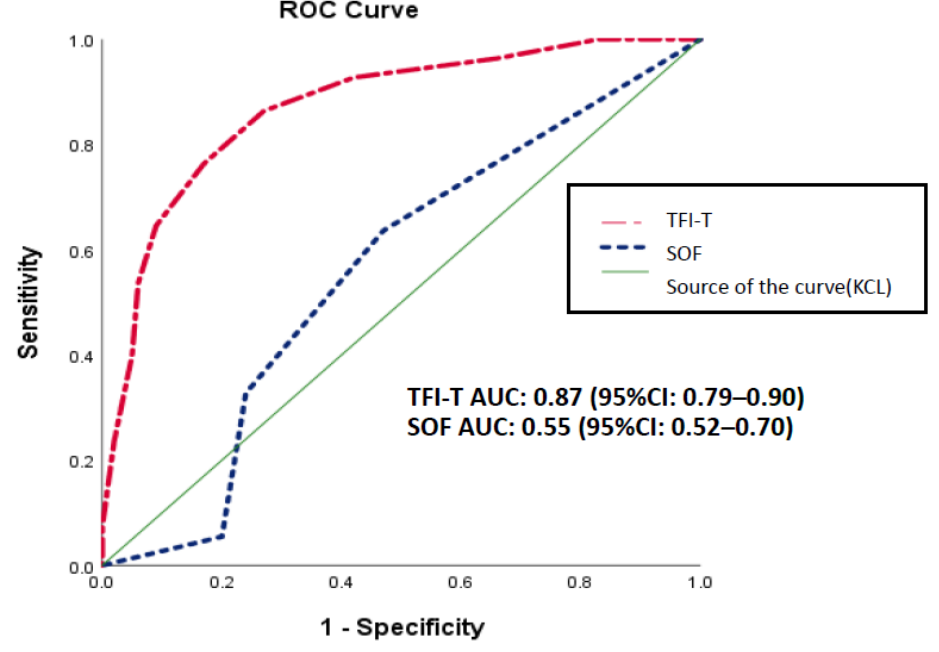
Figure 1. ROC curve of the TFI-T for establishing a cutoff score for frailty.